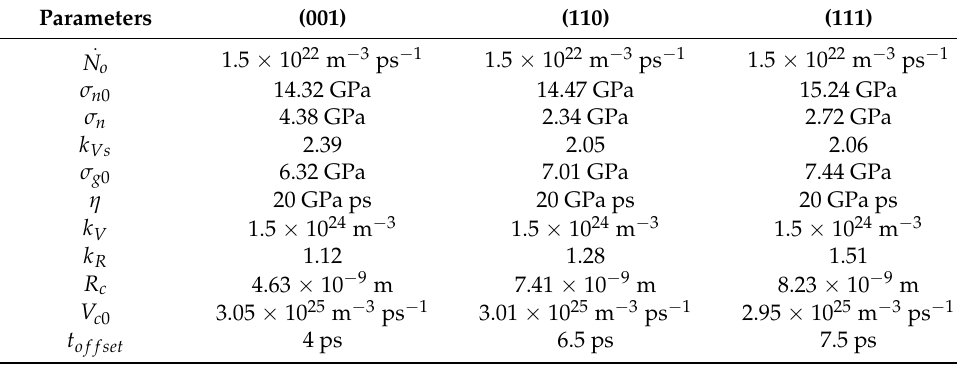
Table 2. Fitted MNAG parameters for different orientations in shock loaded single-crystal Ta. Parameters